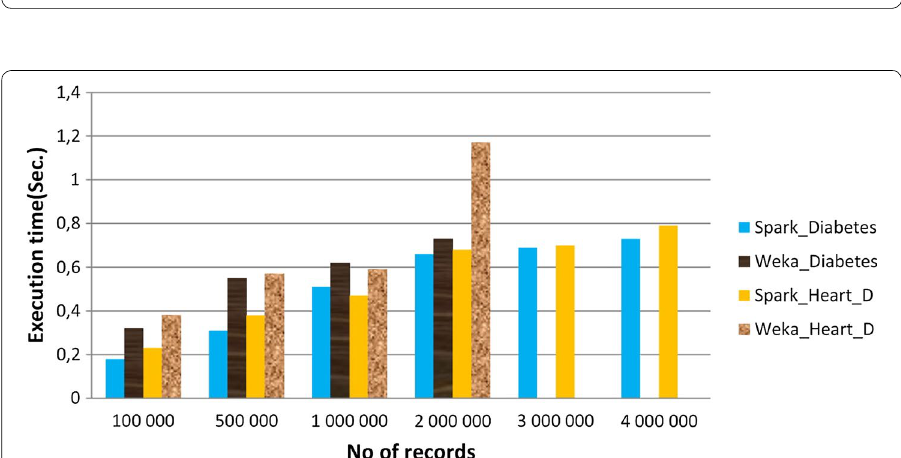
Fig. 10 Execution time comparison of DT using Spark and standard DT : time taken to test